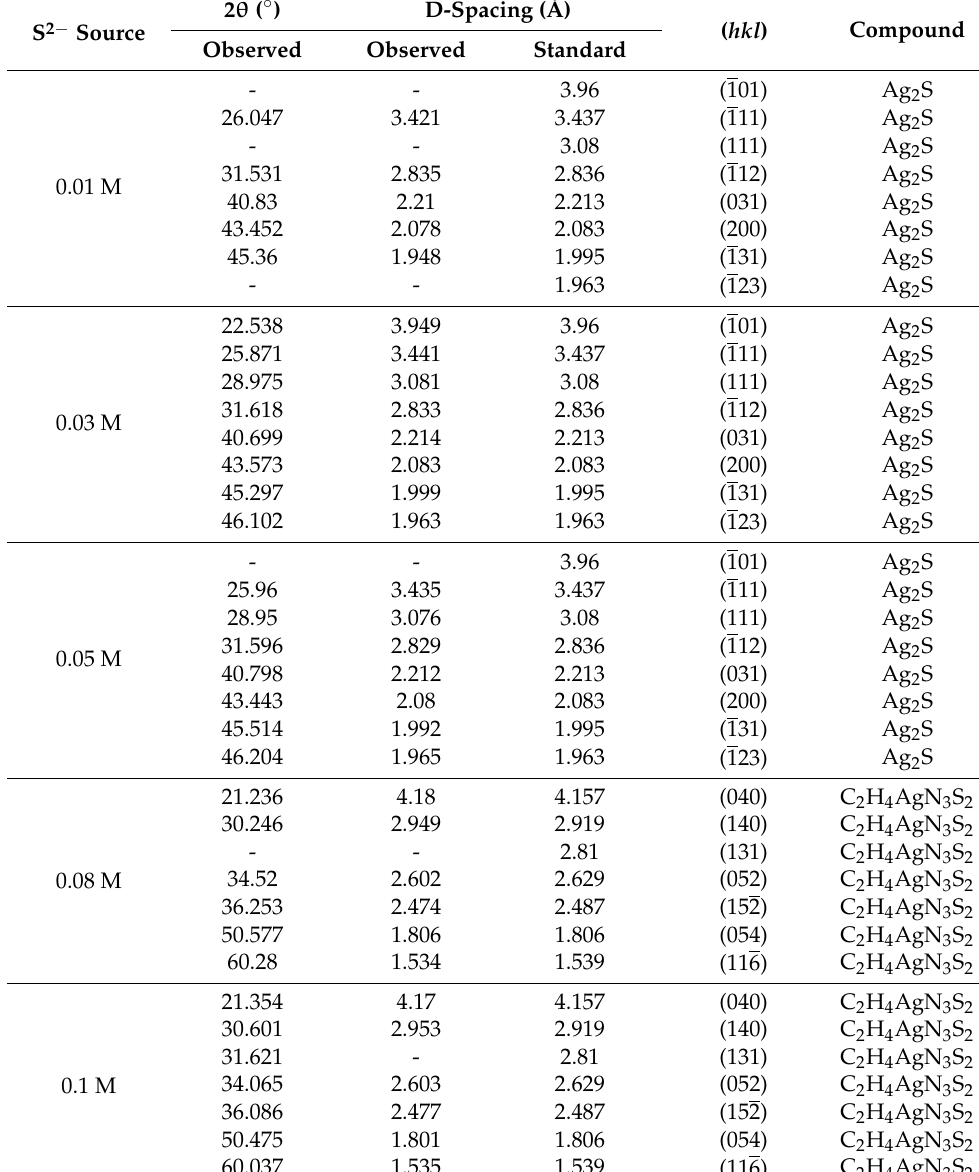
Table 2. XRD data for Ag 2 S/ZnO NRs deposited at various concentrations of CS(NH 2 ) 2 . S 2 − Source Compound